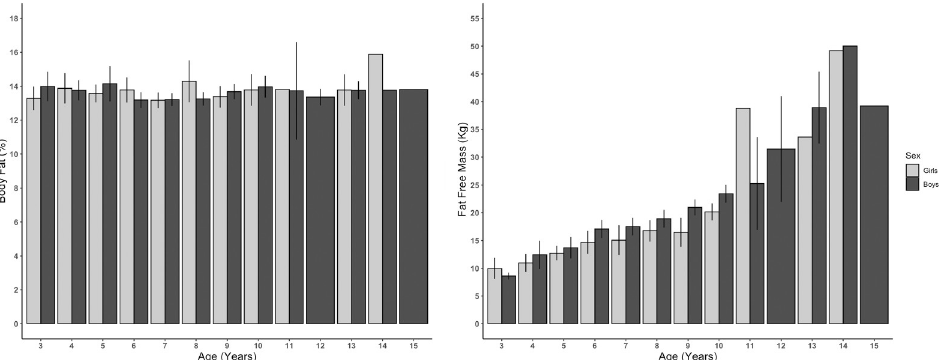
Fig 4. Percent body fat and fat free mass of boys (n = 208) and girls (n = 122) by age category (man ± SE) (n = 330).